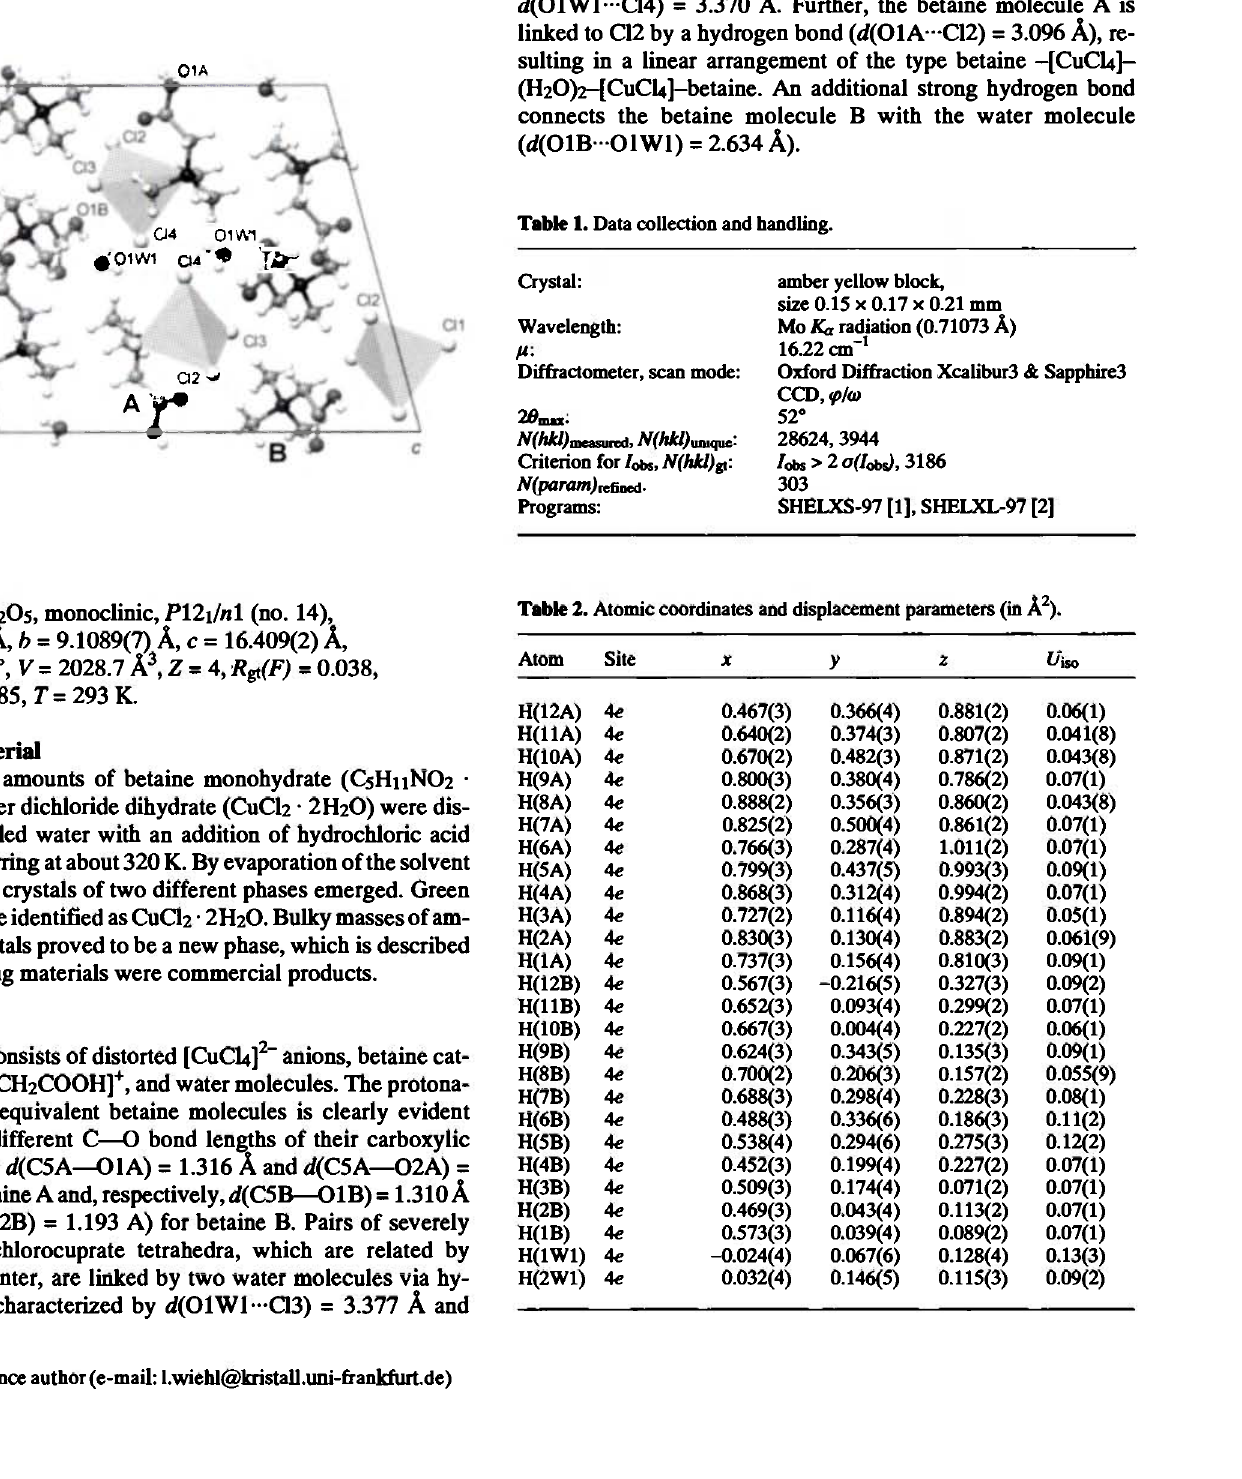
Table 1. Data collection and handling.